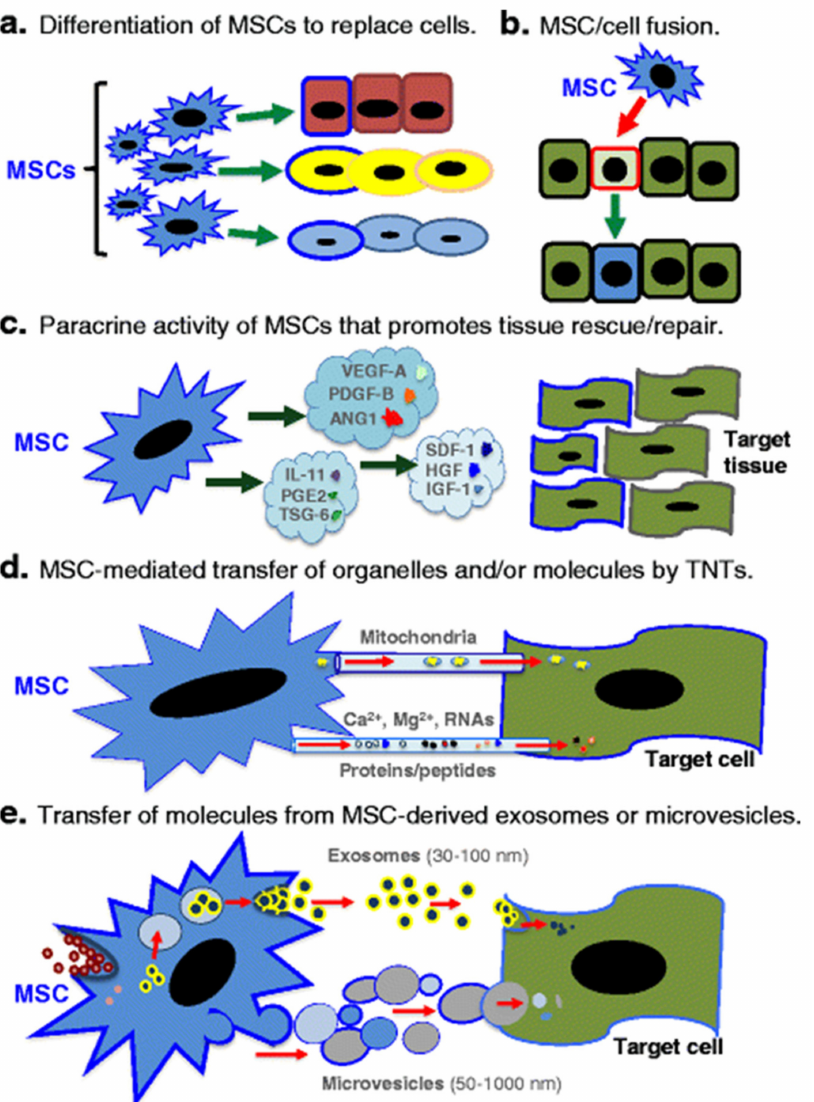
Figure 4. Diverse mechanism of actions of MSCs in rescuing and/or repairing injured cells and tissues. ( a ) Differentiation into replacement cell types. ( b ) Rescue of damaged or dying cells through cell fusion. ( c ) Secretion of paracrine factors such as growth factors, cytokines, and hormones. VEGF vascular endothelial growth factor, PDGF platelet-derived growth factor, ANG1 angiopoietin-1, IL-11 interleukin-11, PGE2 prostaglandin E2, TSG-6 TNF-stimulated gene-6, SDF-1 stromal-derived factor-1, HGF hepatocyte growth factor, IGF-1 insulin-like growth factor-1. ( d ) Transfer of or- ganelles (e.g., mitochondria) and/or molecules through tunneling nanotubes ( TNTs ). Ca 2+ cal- cium, Mg 2+ magnesium. ( e ) MSC-mediated transfer of proteins/peptides, RNA, hormones, and/or chemicals by extracellular vesicles such as exosomes or microvesicles. Exosomes are generated through the endocytic pathway and released through exocytosis. By contrast, microvesicles are produced by cell surface budding and released directly from the plasma membrane. VEGF: vas- cular endothelial growth factor, PDGF: platelet-derived growth factor, ANG1: angiopoietin-1, IL-11: interleukin-11, PGE2: prostaglandin E2, TSG-6: TNF-stimulated gene-6, SDF-1: stromal- derived factor-1, HGF: hepatocyte growth factor, IGF-1: insulin-like growth factor-1, Ca 2+ : calcium, Mg 2+ : magnesium. Source: Spees et al.